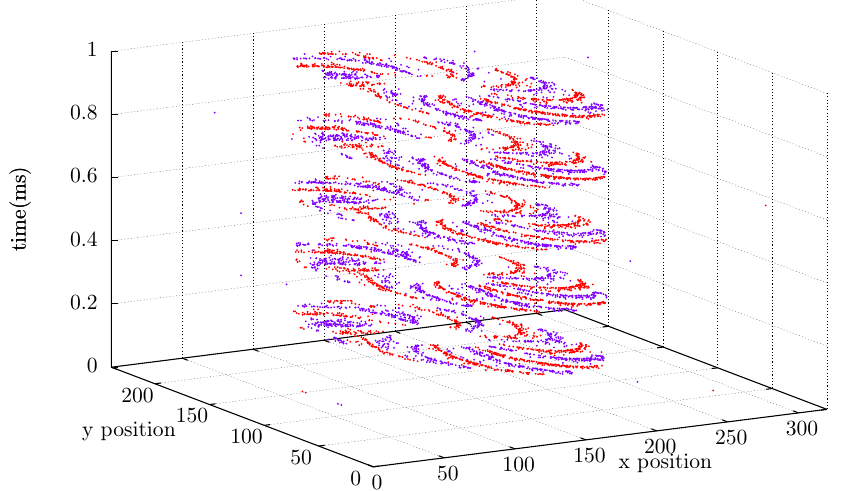
Figure 3. Stream data view of fan events with eight blades rotating. Coordinates x and y in the horizontal plane and timestamp in ms at the vertical axis.